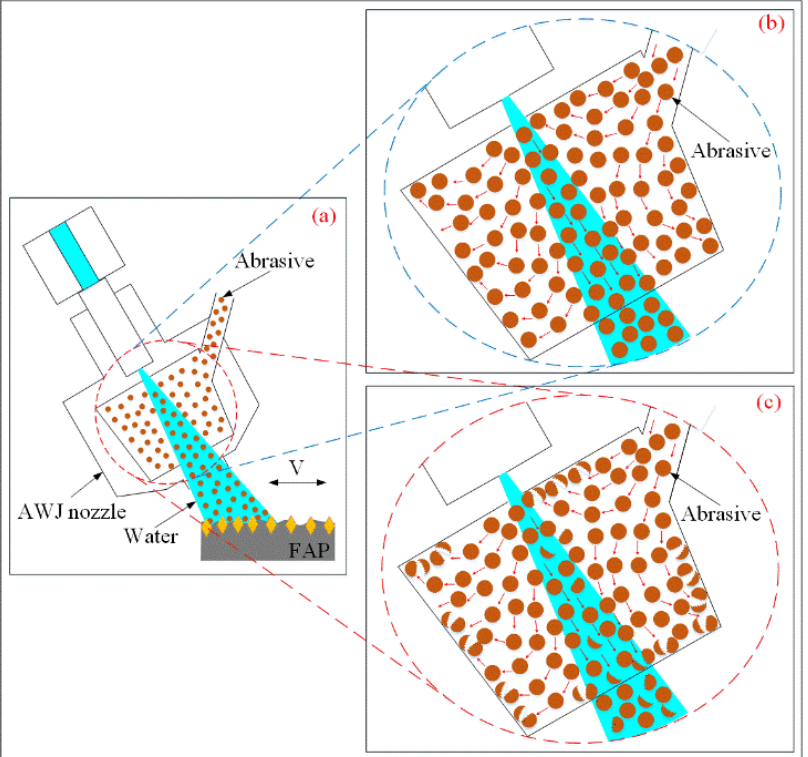
Figure 15. Schematic diagram of AWJ dressing the FAP: ( a ) schematic diagram of AWJ dressing; ( b ) 4 MPa AWJ dressing diagram; ( c ) 5 MPa AWJ dressing diagram.